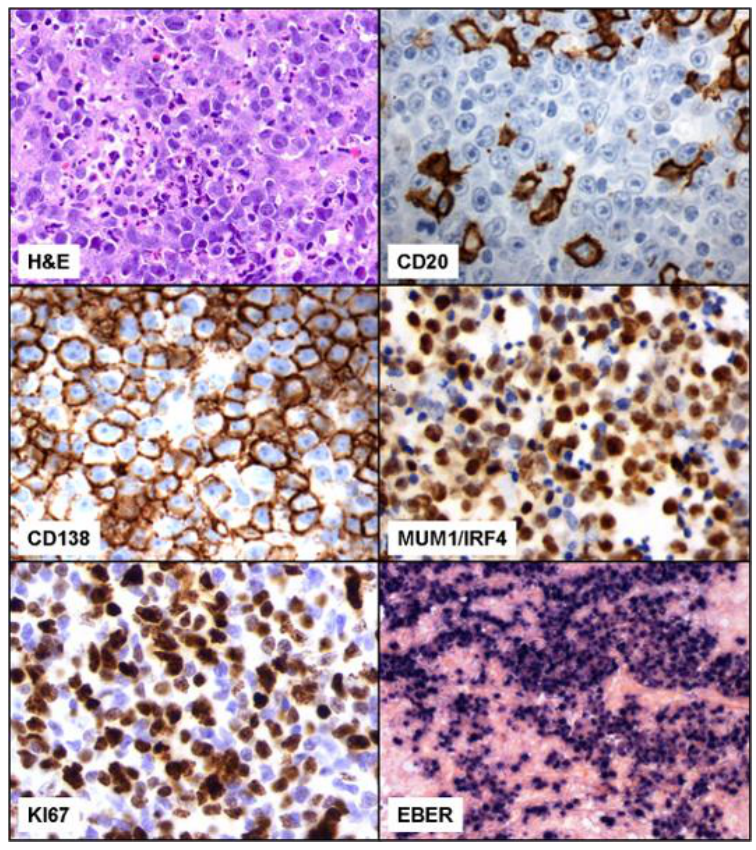
FIGURE 1. Representative case of PBL. In the H&E stain, a heterogeneous population of large cells with plasma cell–like appearance is shown (IHC, 100  ). PBL cells are CD20 negative (IHC, 400  ), CD138 (IHC, 400  ), and MUM1/IRF4 positive (IHC, 400  ), and show a high Ki67 expression (IHC, 400  ). PBL exhibits positive EBER expression by in situ hybridization (ISH, 40 